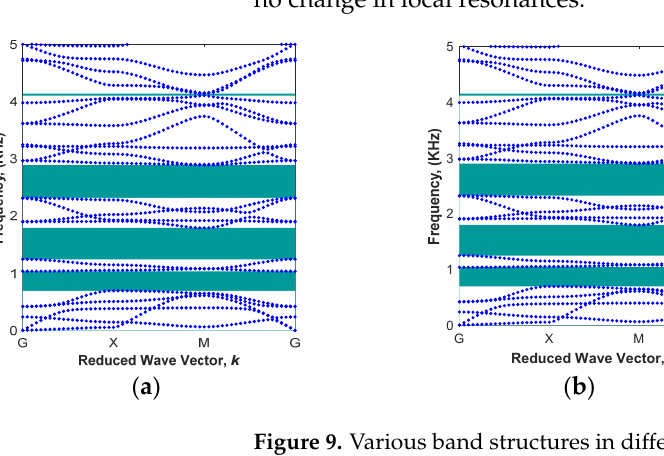
of various iron volume fractions on the wave propagation analysis. Material properties of